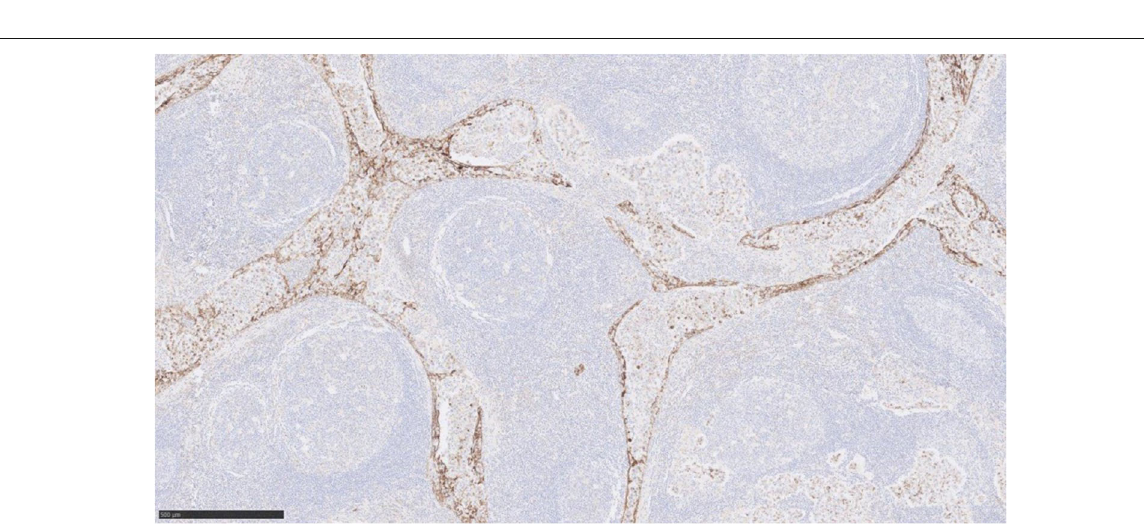
Fig. 8 Immunohistochemistry CKAE1/3, image × 5 magnification, shows the perinuclear dot-like pattern in the seminoma